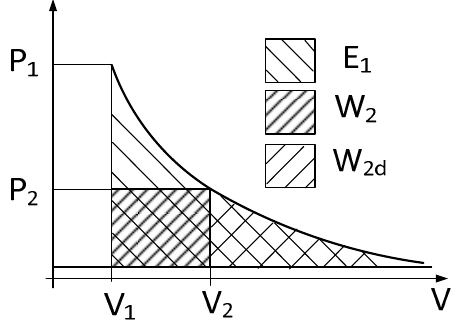
Figure 3. Pressure-volume diagram of pressurized air work and expansion.